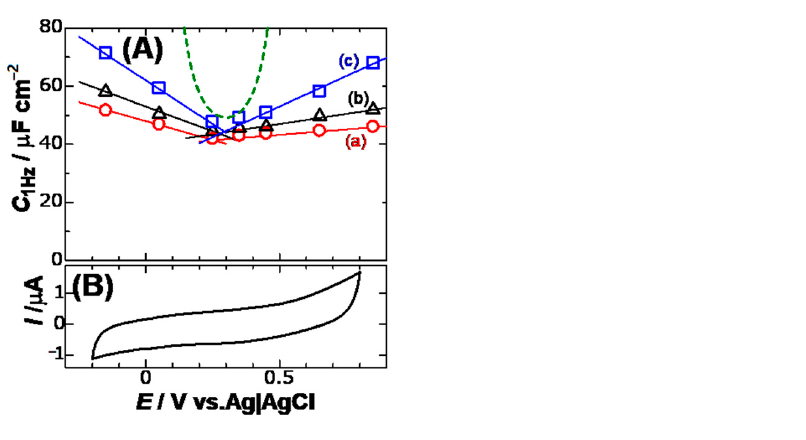
Figure 4. Plots of ( A ) C 1Hz vs. c 2/3 and ( B ) 1/ C 1Hz vs. c -1/2 in (circles) KCl and (triangles) HCl solu- tions. ( A ) is the parallel model by Equation (6), whereas ( B ) is the series (Stern) model by Equation (7).